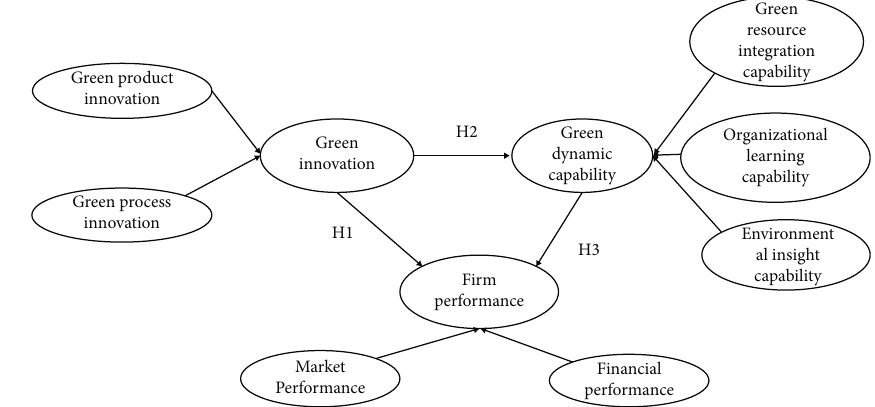
Figure 1: Conceptual framework. Table 1: Respondent demographics.